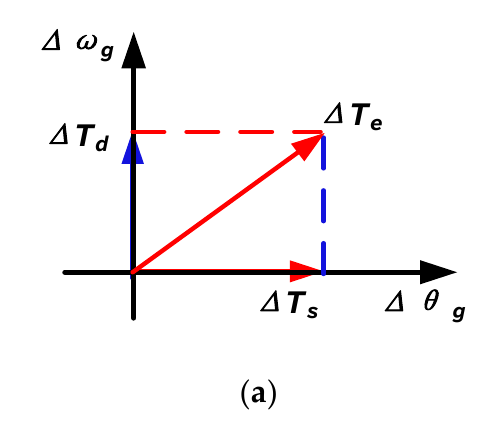
Figure 7. Phasor diagram for demonstrating the leading effect of damping torque on internal voltage stability: ( a ) normal condition; ( b ) abnormal condition with changed damping torque under disturbances.